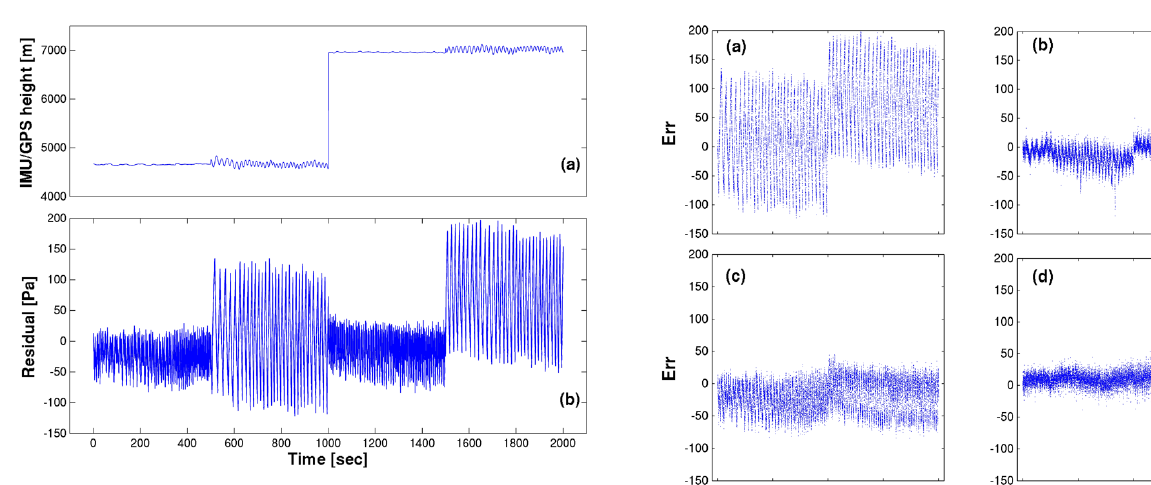
Fig. 10. Concatenated time series as in Fig. 8: (top panel) aircraft height [m] (m.s.l.); and (bottom panel) pressure error determined from IMU/dGPS before correction [Pa].